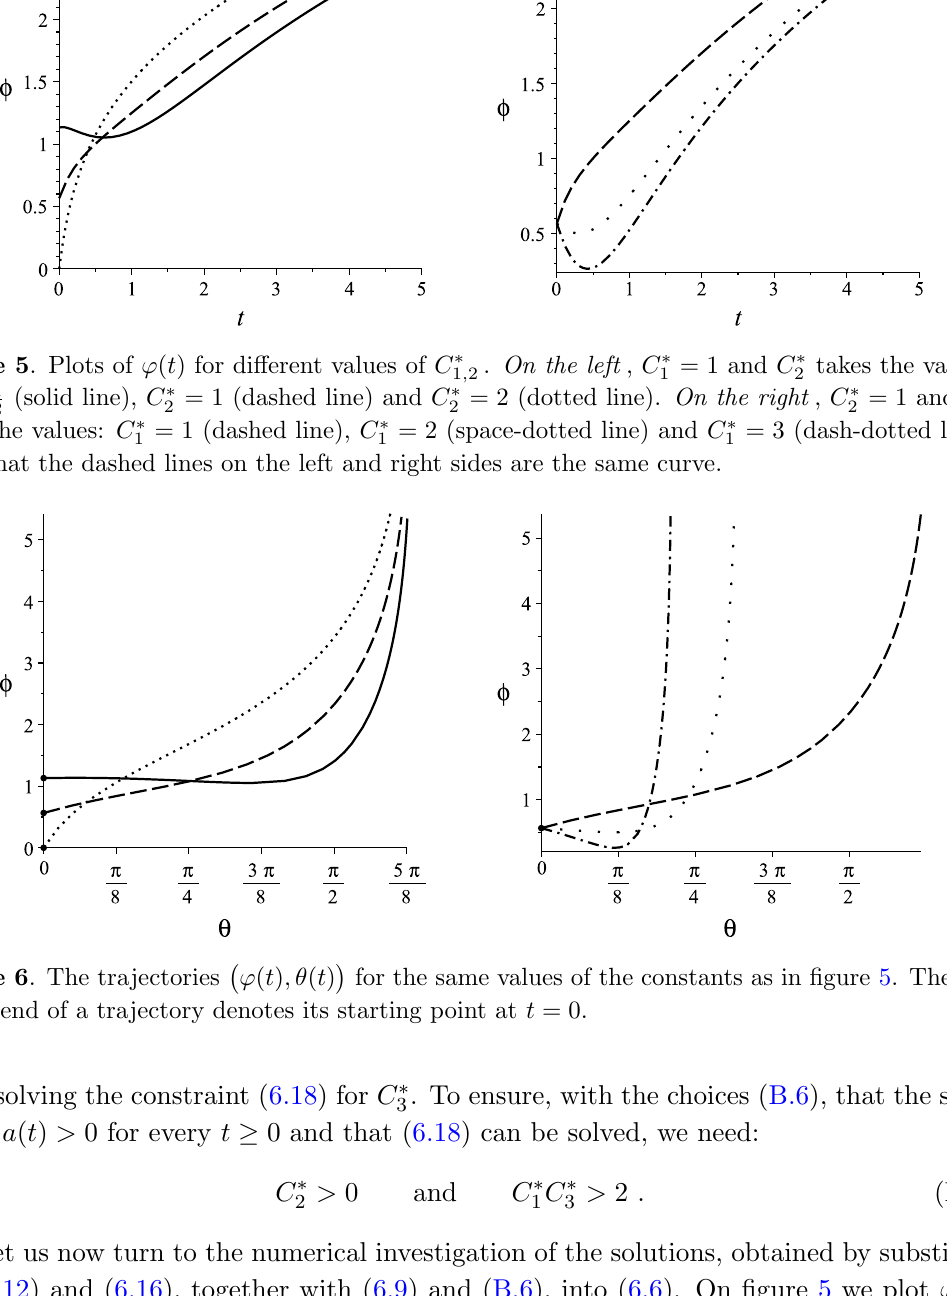
Figure 6 . The trajectories at one end of a trajectory denotes its starting point at t =